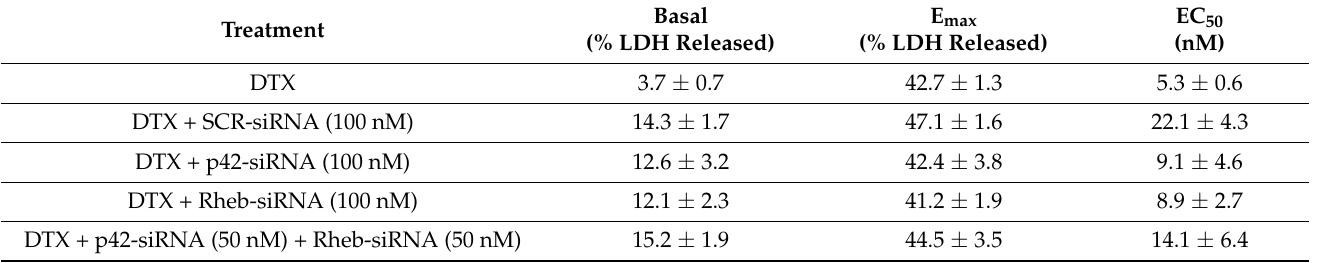
Table 2. DTX-induced toxicity and EC50 values. PC3 prostate cancer cells were exposed to DTX (0.1 nM to 1 µ M) alone or in the presence of different siRNA treatments for 72 h and toxicity deter- mined. Individual DTX dose–response curves were fitted to a log concentration versus response model. Data represent mean ± SEM of 4 to 7 experiments.